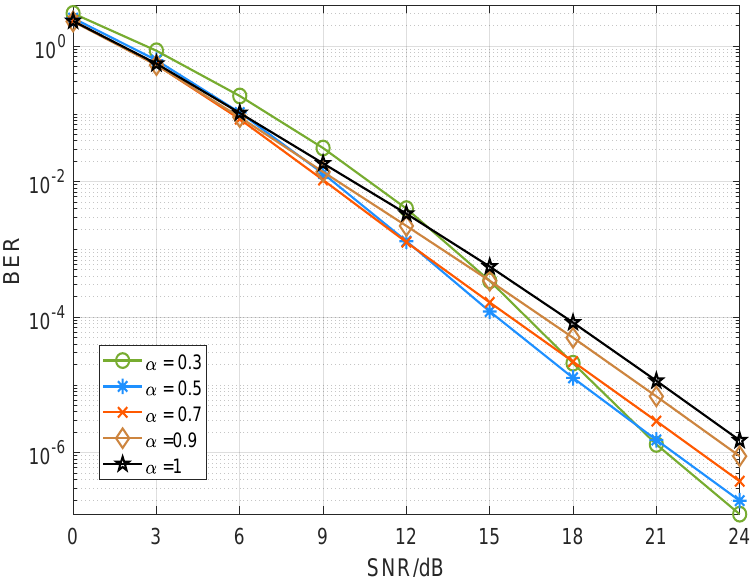
Figure 4. BER performance of the quadrature phase shift keying modulated STBC-VBLAST-TPA system of α = 0.3,0.5,0.7,0.9,1 having M = 3 and N =